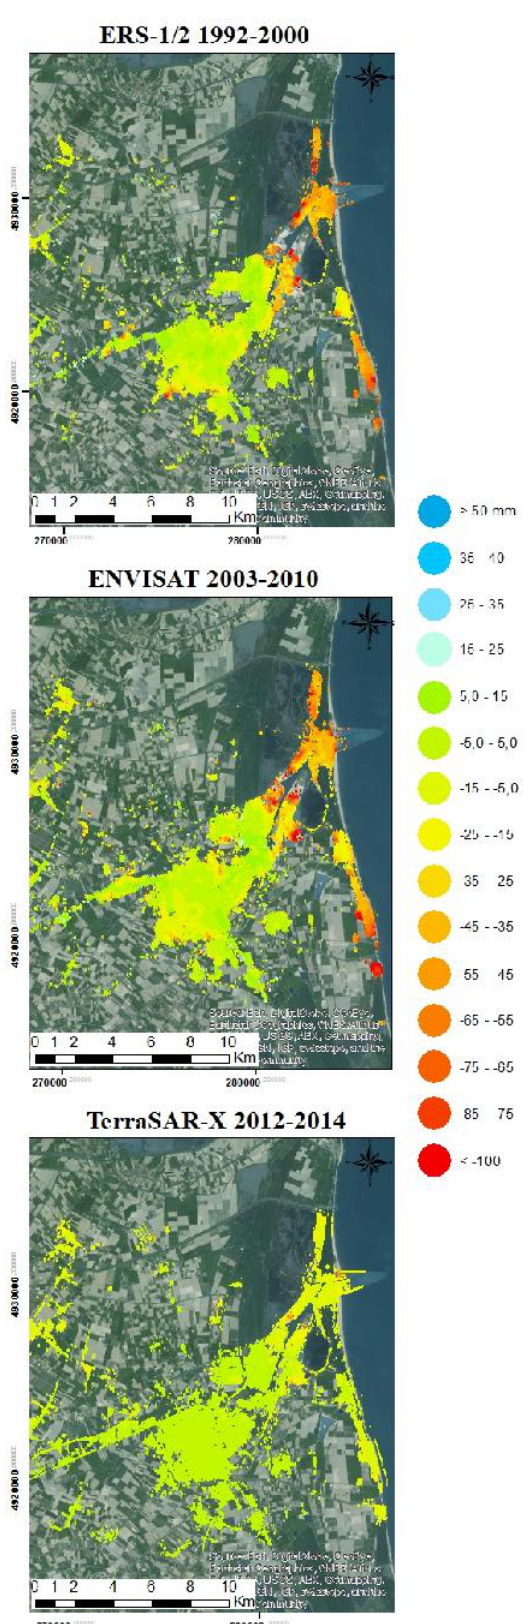
Figure 6. Displacement maps obtained with SBAS. Negative values, in red, represent subsidence.